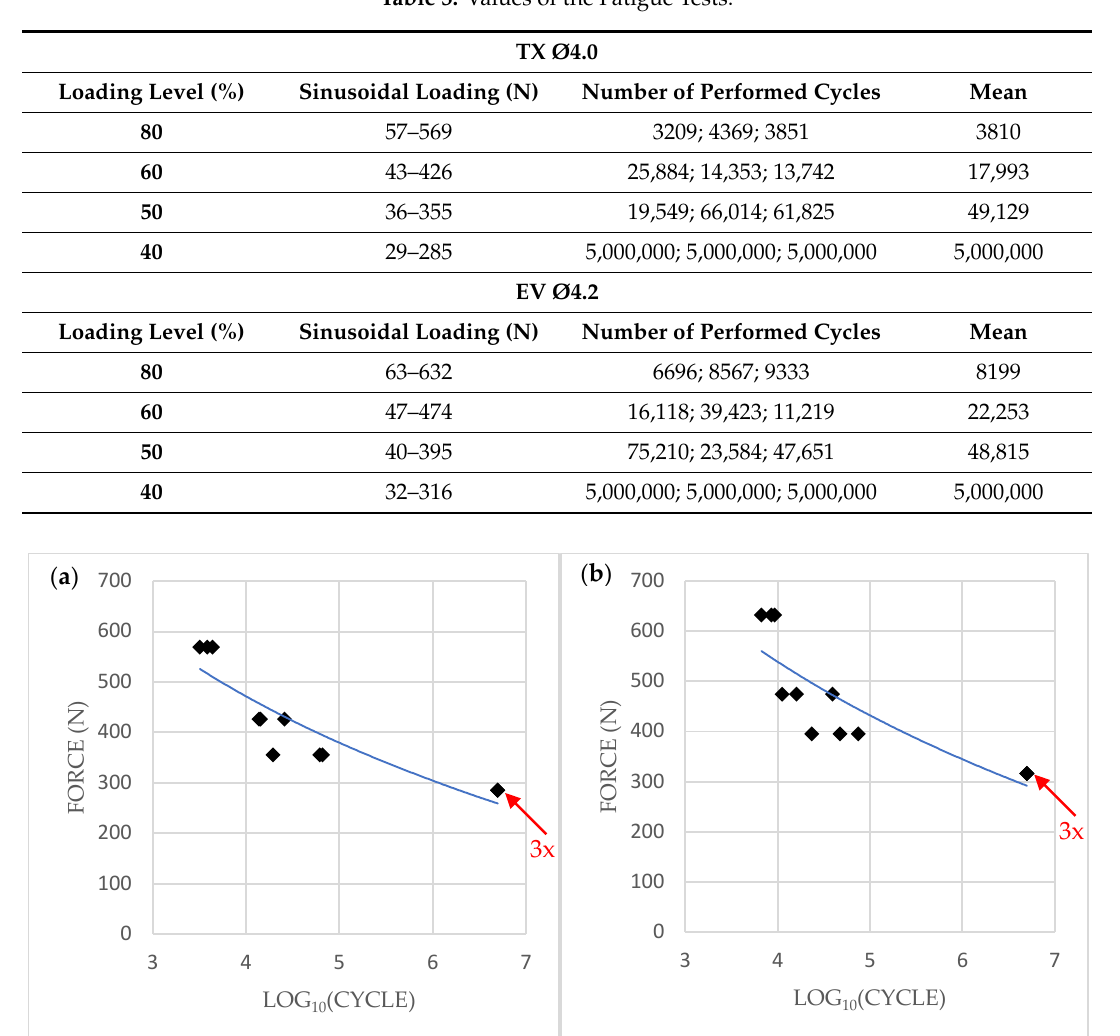
Table 3. Values of the Fatigue Tests.